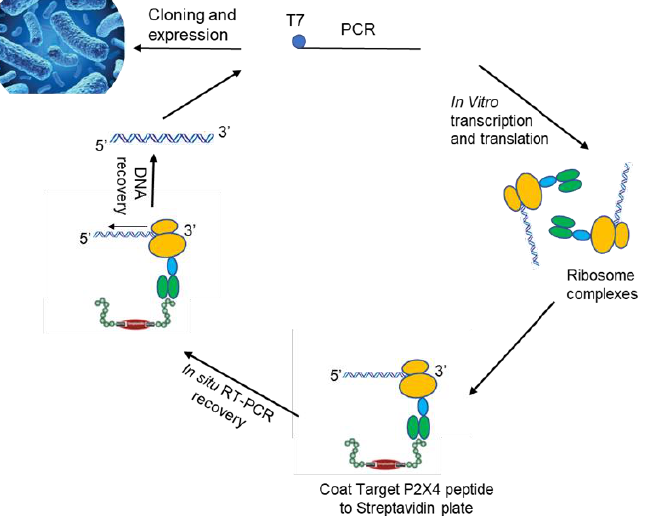
Figure 1. Overview of eukaryotic ribosome display selection, isolation and efficacy of anti-P2X4R scFv antibodies. Schematic of stalled ARM complex and position of primers used for RT-PCR recovery in the first, second, and third cycles of ribosome display. The resulting library was converted to ribosome display format for transcription to mRNA, translation, and selection.